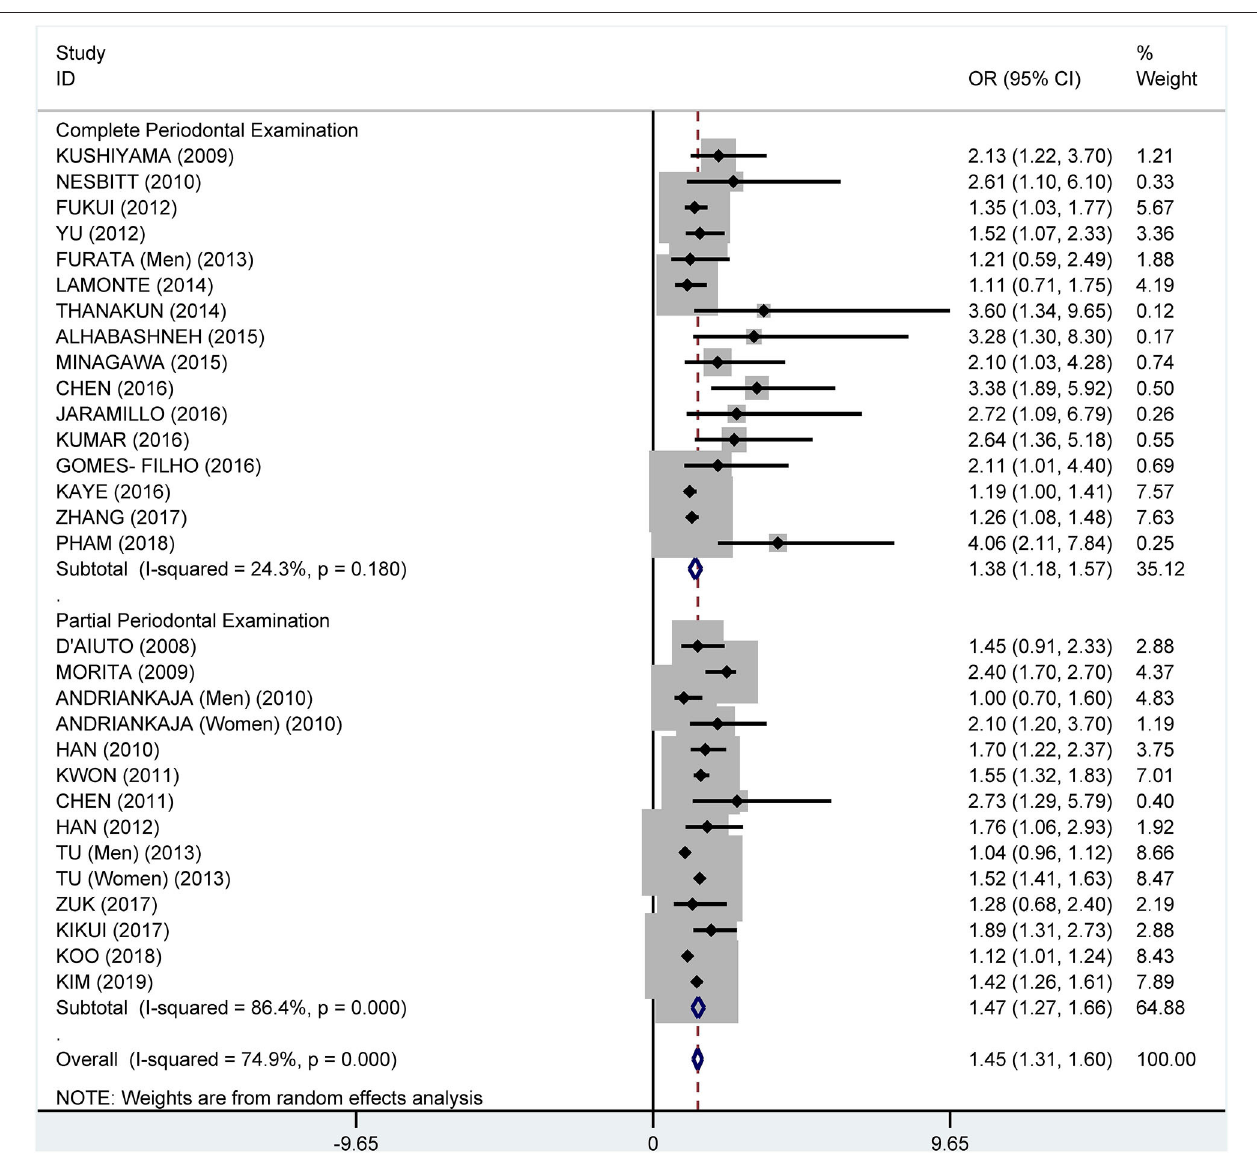
FIGURE 6 | Subgroup analysis of pooled adjusted odds ratios of the association between periodontitis and metabolic syndrome by the method of examination used to diagnose